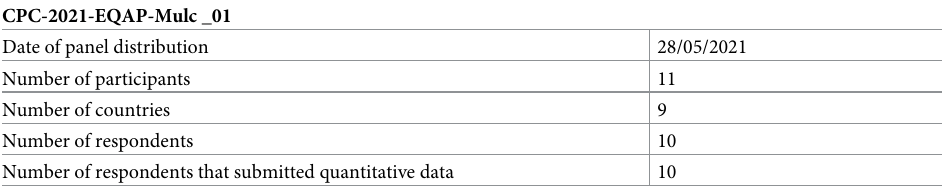
Table 2. Participants in the first round BU-LABNET EQA